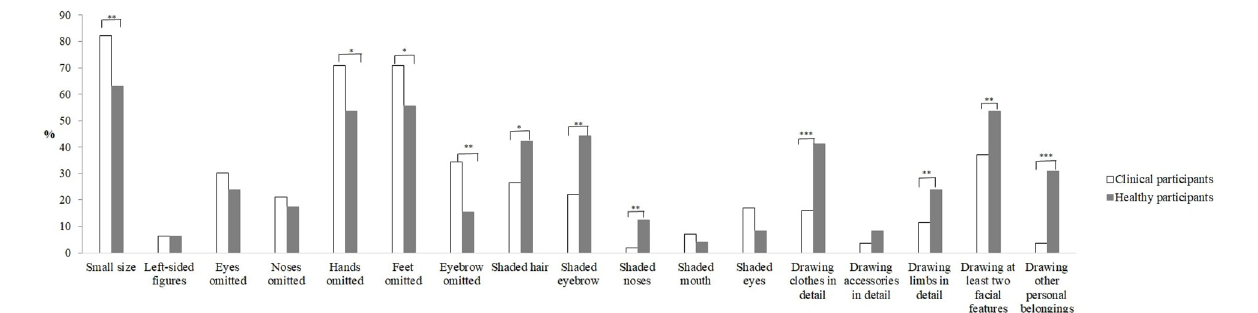
FIGURE 1 | Frequency of drawing features and sex in clinical participants and healthy participants.